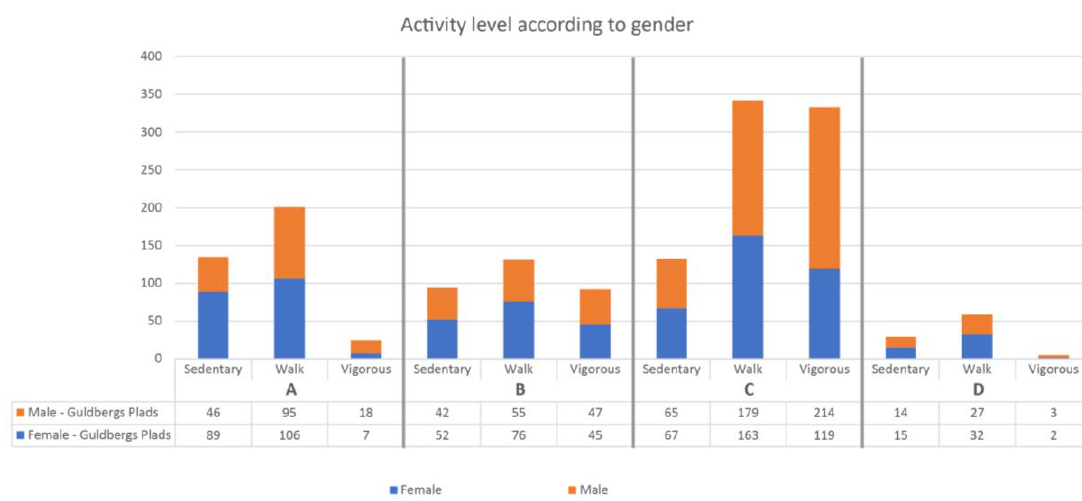
Figure 6. Observed gender distribution across the sub-areas of the space. It can be seen that there is the most vigorous activity in sub-area